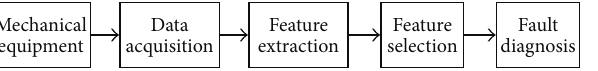
Figure 2: Architecture of fault diagnosis system.